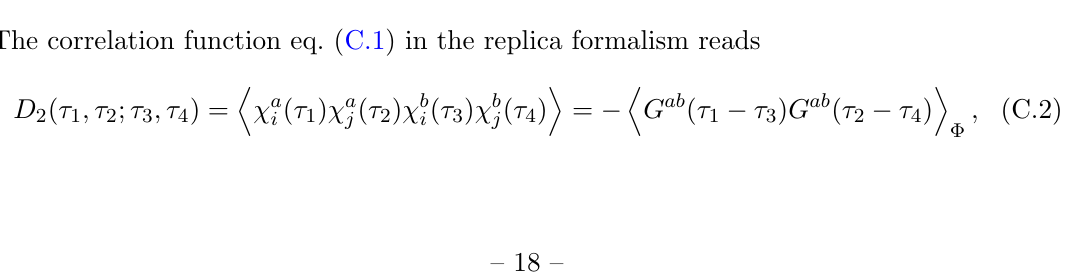
Figure 5 . Diagram for the correlation function D over